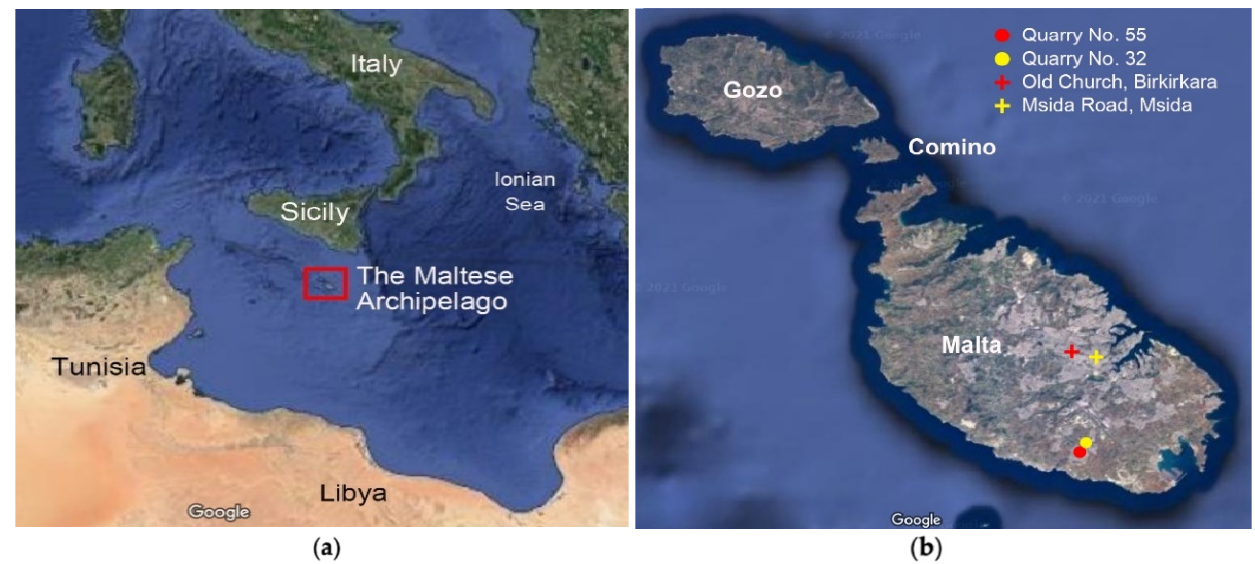
Figure 1. The Maltese Archipelago: ( a ) location with respect to the Mediterranean Basin; ( b ) the main habitable islands; the location of case-studies is also included (© Google Earth).